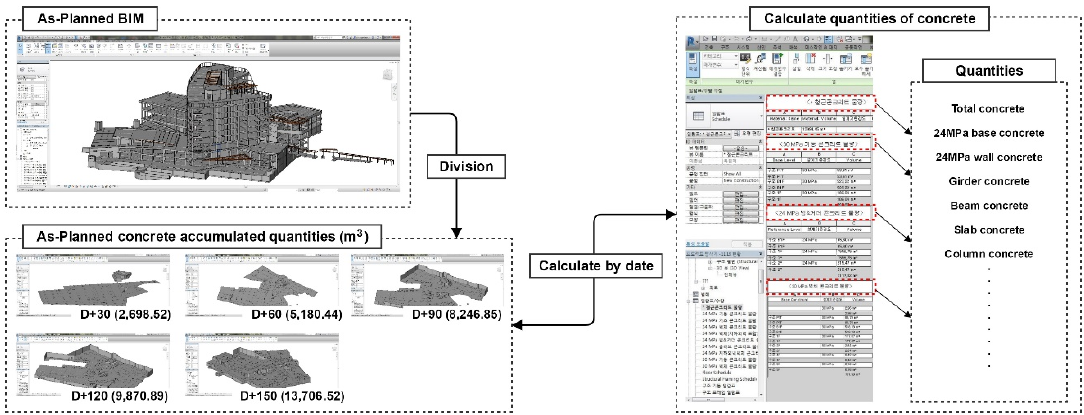
Figure 6. As-planned 3D view BIM template and the achievement quantity.